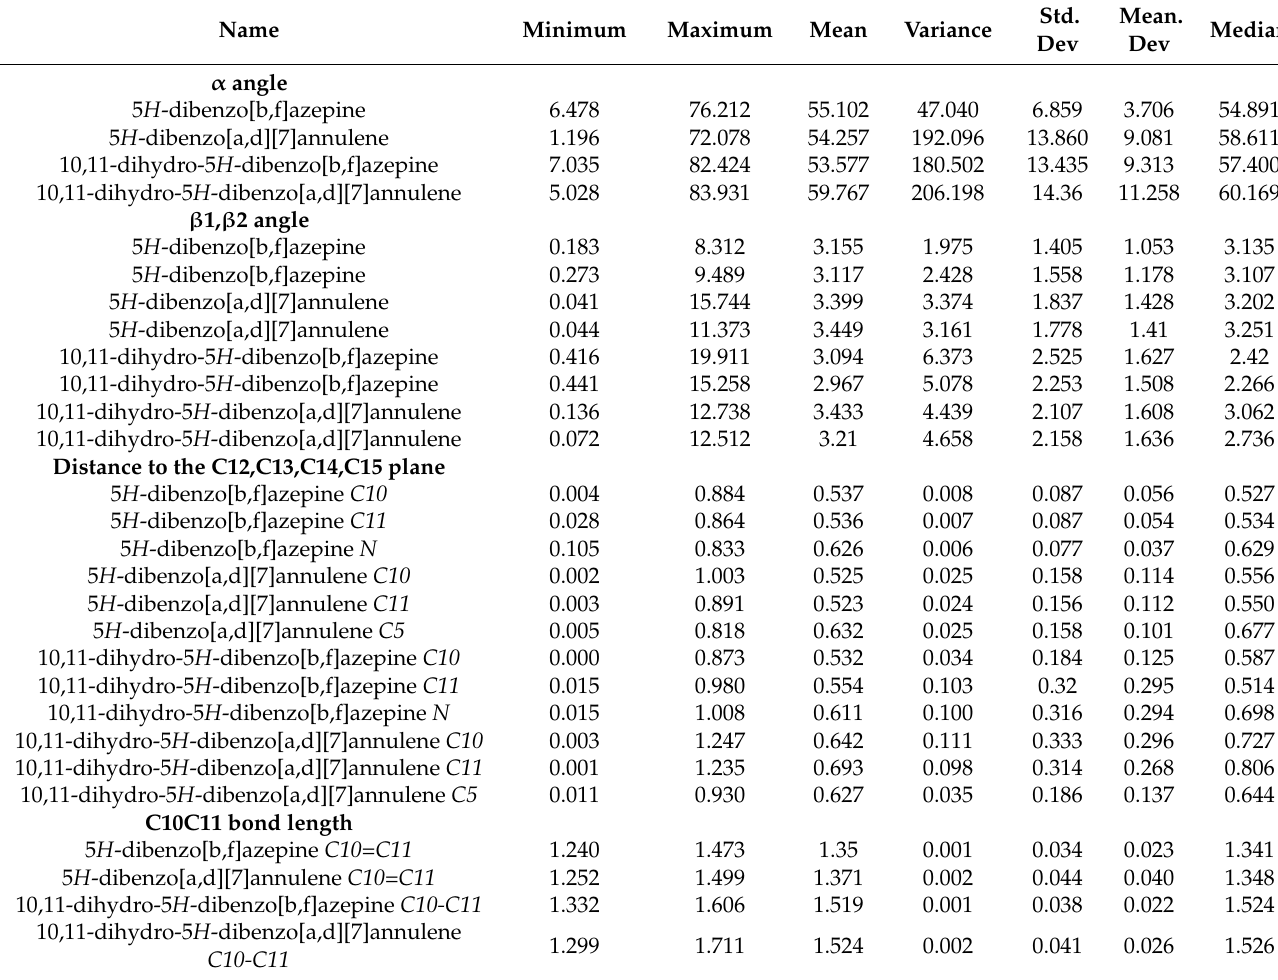
Table 2. Analyzed geometrical parameters for the investigated